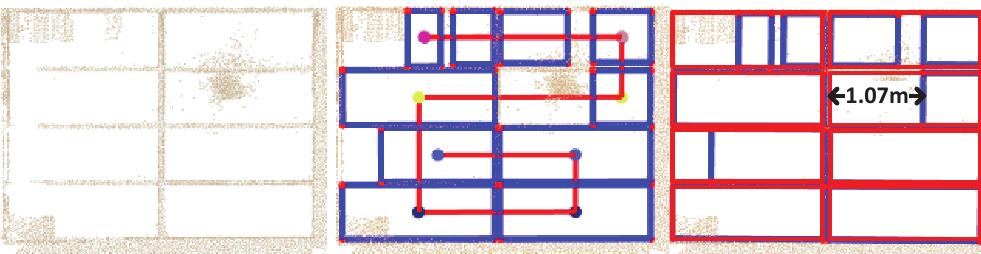
Figure 14. A complex example selected from the high clutter dataset (Fire Brigade). From the left to right, the sample of wall points; reconstructed openings (blue frames) with associations (red lines); the comparison to manually labeled openings (red frames).